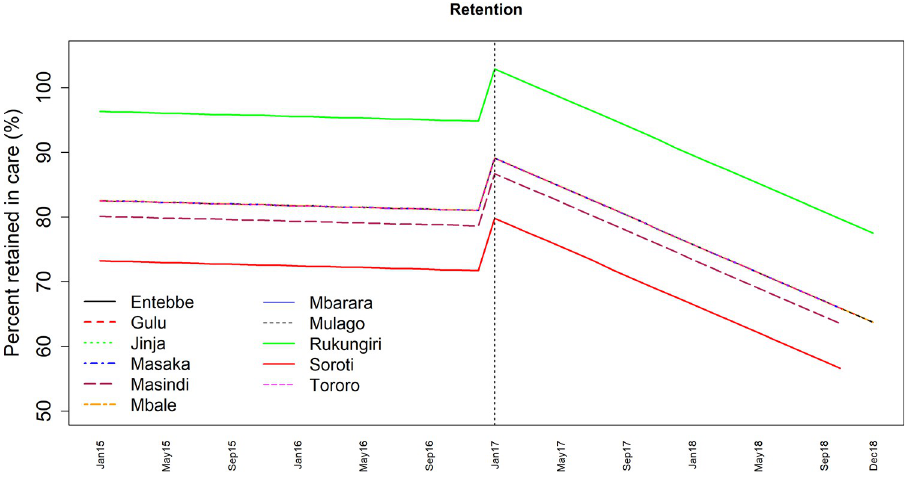
Fig 4. Time series trends showing predicted six-month retention for cohorts enrolled in each month from January 2015 through December 2018 comparing pre-UTT (2015–2016) and UTT (2017–2018) periods separated by a vertical dotted